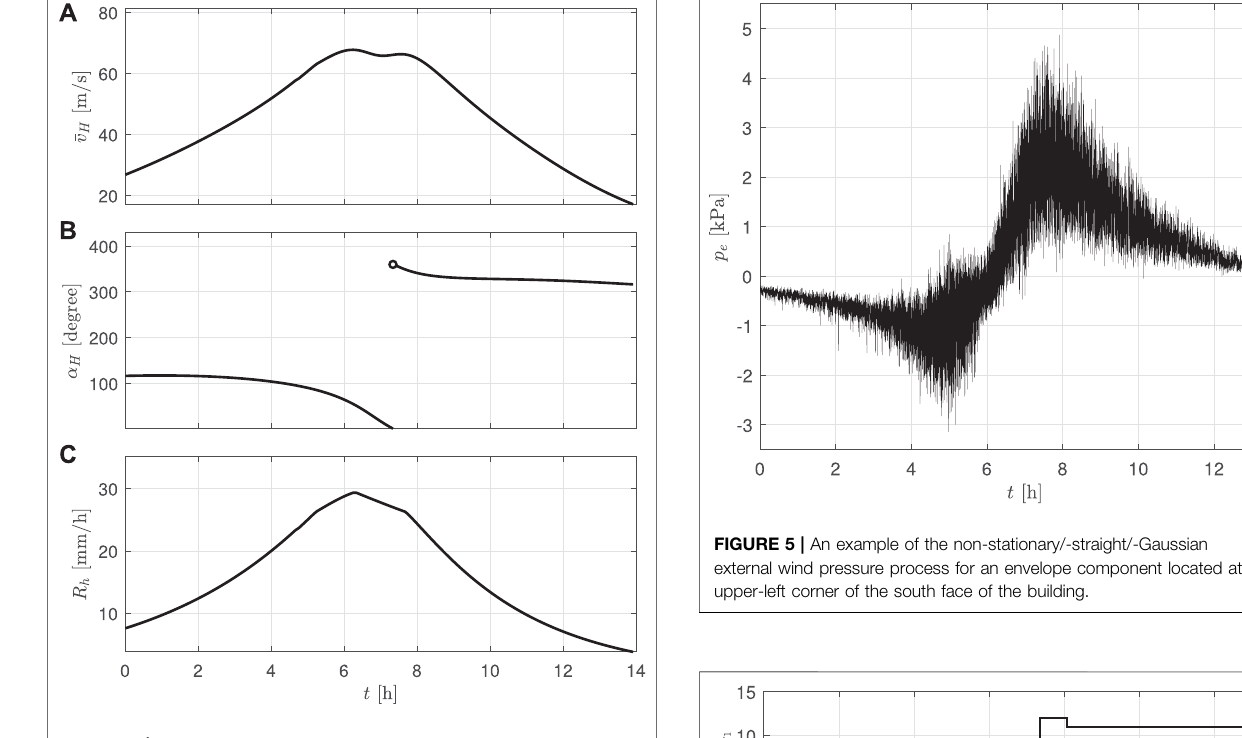
FIGURE 4 | The simulated category V hurricane in Saf fi r-Simpson scale measuredatthebuildingsite: (A) evolutionofthemeanhourlywindspeed; (B) wind direction; and (C) mean hourly rainfall intensity.